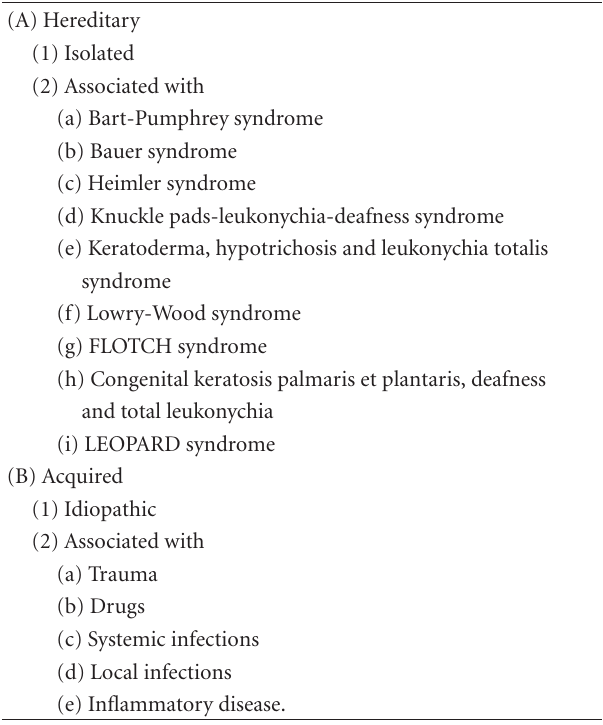
Table 1: Classification of true